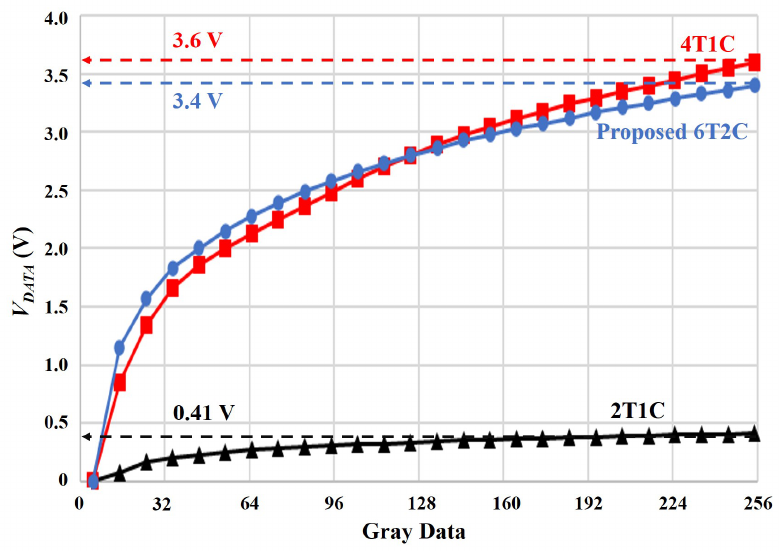
Figure 6. Extended V DATA ranges of 6T2C and 4T1C circuits, compared to the narrow one of the 2T1C